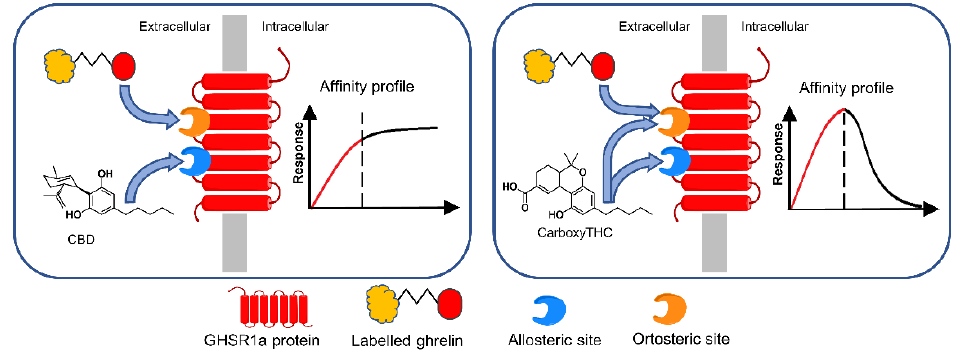
Figure 4. Biosensing principle of CBD and carboxy-THC detection according to their affinity profile in direct competitive assay with HRP-labeled ghrelin. The immobilized recognition element was GHS-R1a. Reproduced from [26] with permission from Elsevier.